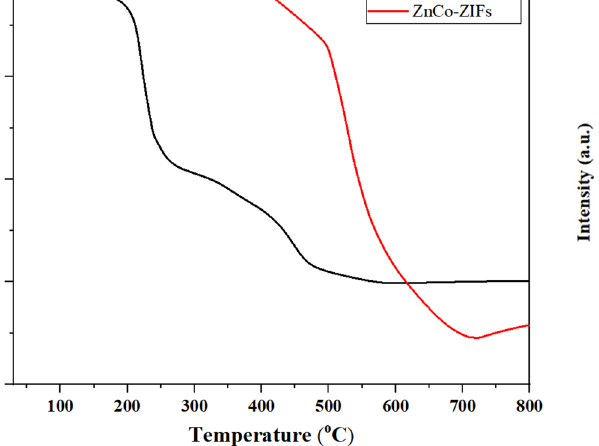
Figure A2: SEM images of Ag/ZnCo - ZIFs at di ff erent magni fi cation